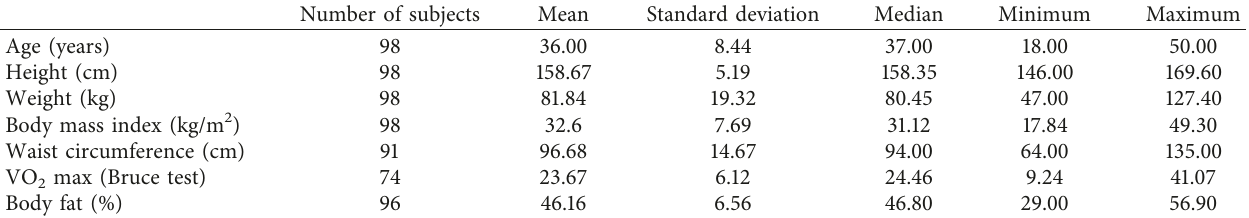
Table 1: Characteristics of subjects.